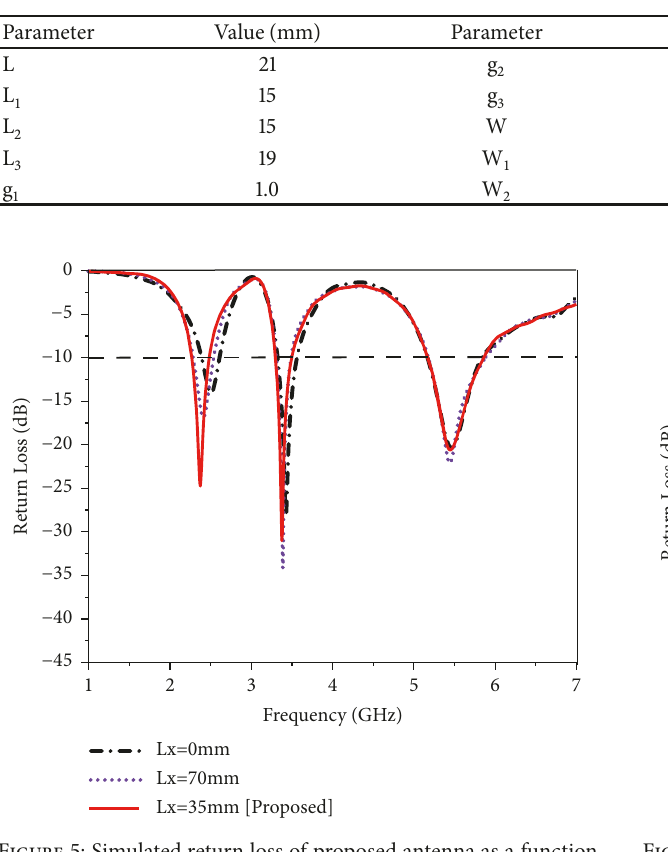
Figure 4: Simulated return loss and input impedance ( Ω ) of the proposed antenna as a function of tuning stub n (a 2 × b 2 ). Table 1: Optimized values of the proposed antenna.